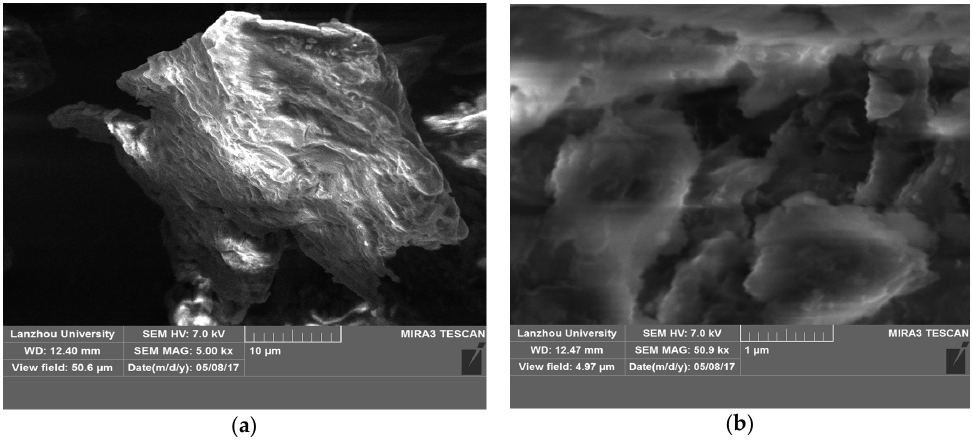
Figure 2. SEM of β -CD(AN- co -AA) hydrogel particles in different resolution size 10 μ m ( a ) and 1 μ m ( b ).